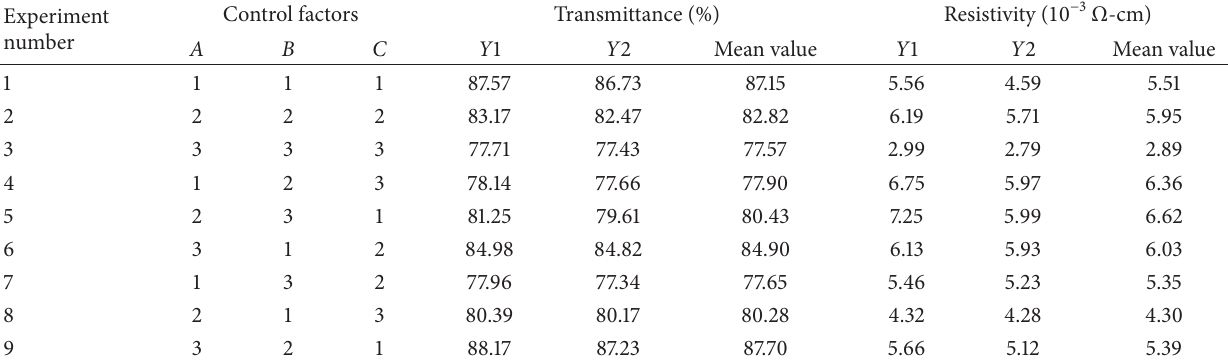
Table 3: Experimental results for the transmittance and resistivity of the deposited ZnO films on glass substrate. Experiment